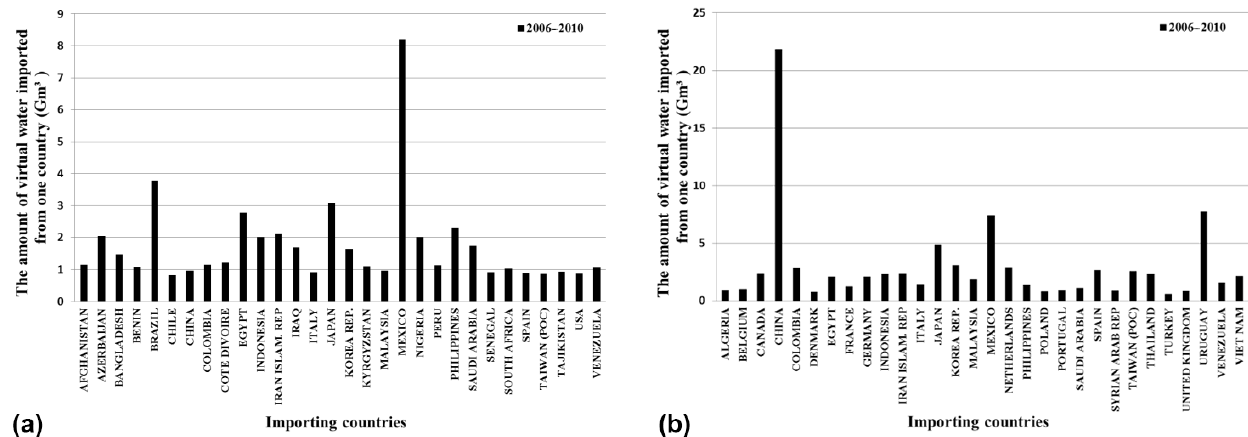
Figure 4. The intensive inflow of virtual water by food and feed crops import. (a) Food crops (wheat, barley, rice, rye, and sorghum) and (b) feed crops (maize and soybean). Table 2. Classification of importers by connectivity and volume of GVWT for food crops (wheat, barley, rice, and others). GVWT of food